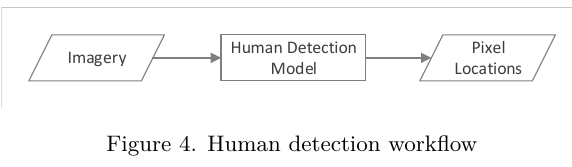
Figure 4. Human detection